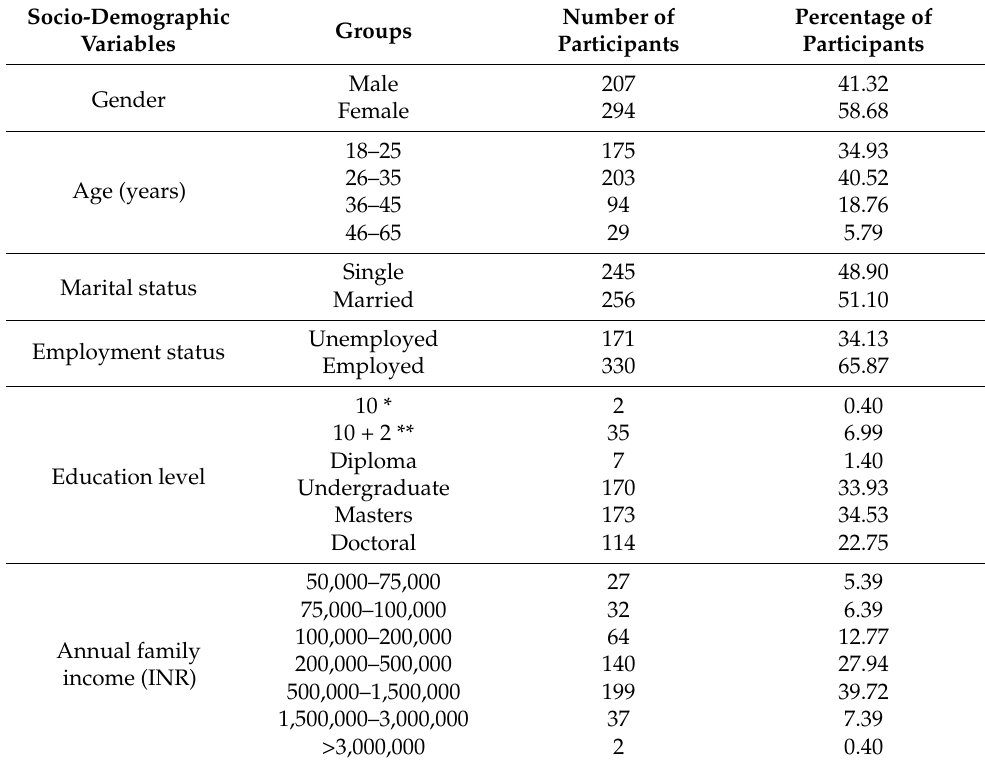
Table 1. Socio-demographic profile of